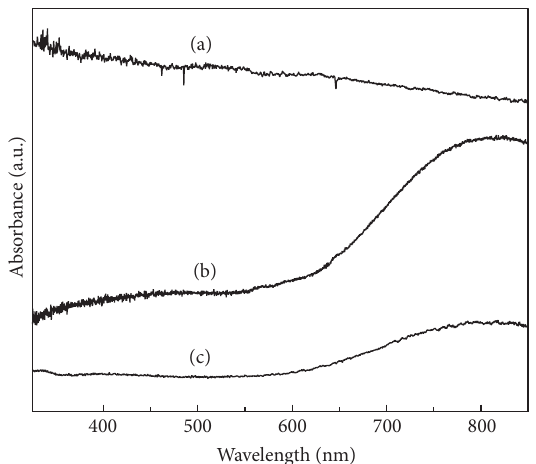
Figure 1: UV-Vis spectrum of (a) ionic solution of copper and (b) copper-amino acids chelate.